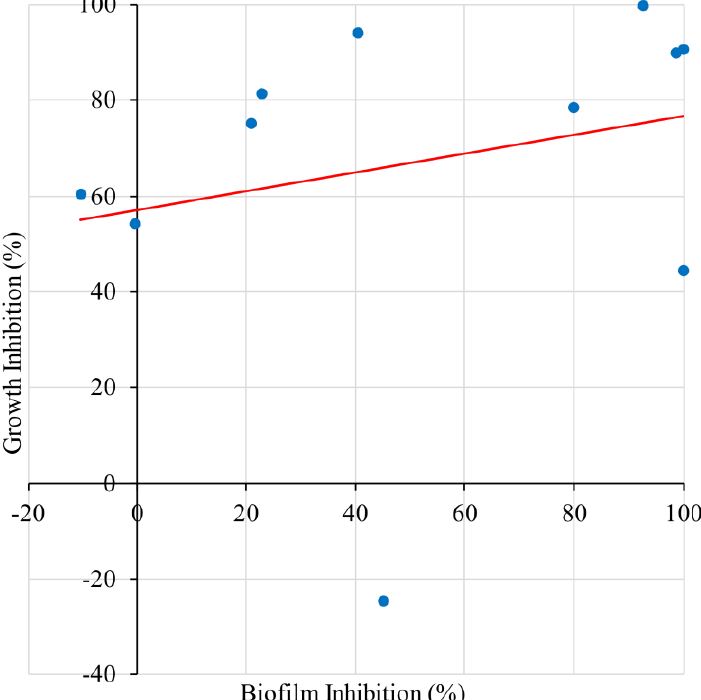
Figure 3. Relationship between biofilm inhibition and growth inhibition. Summary of collected data from cell viability assays and the corresponding biofilm inhibition at the same additive concentration, if available. n = 11. y = 0.20x + 57.13. R 2 = 0.055. p = 0.49.